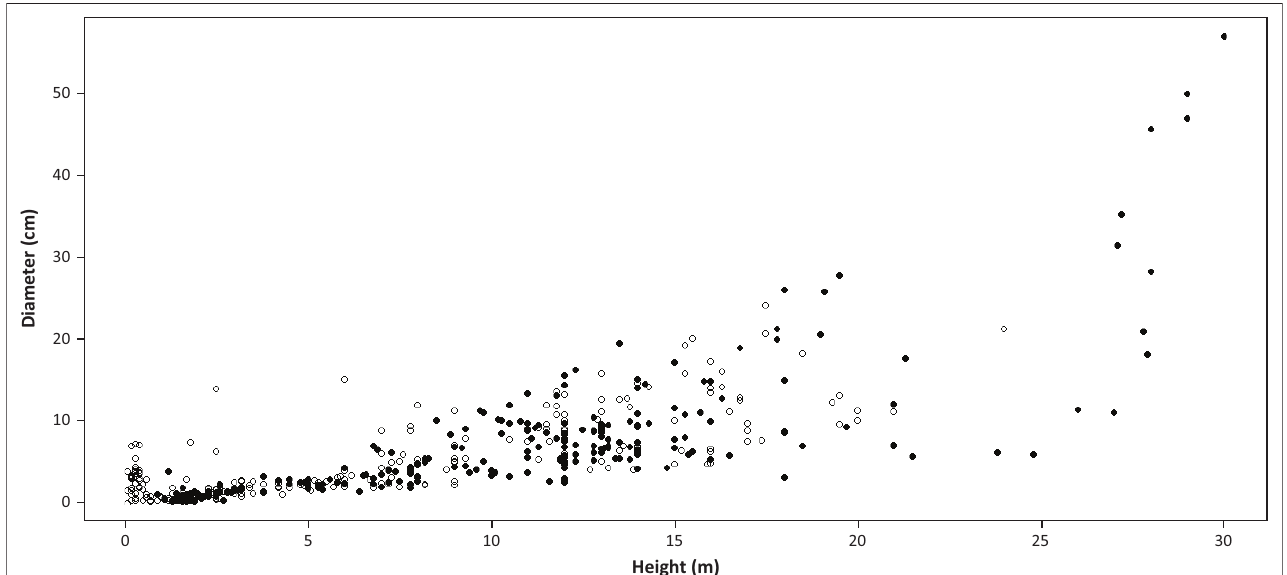
FIGURE 7: Relationship between height and diameter in Graskop (grey circles) and White River (solid black circles).